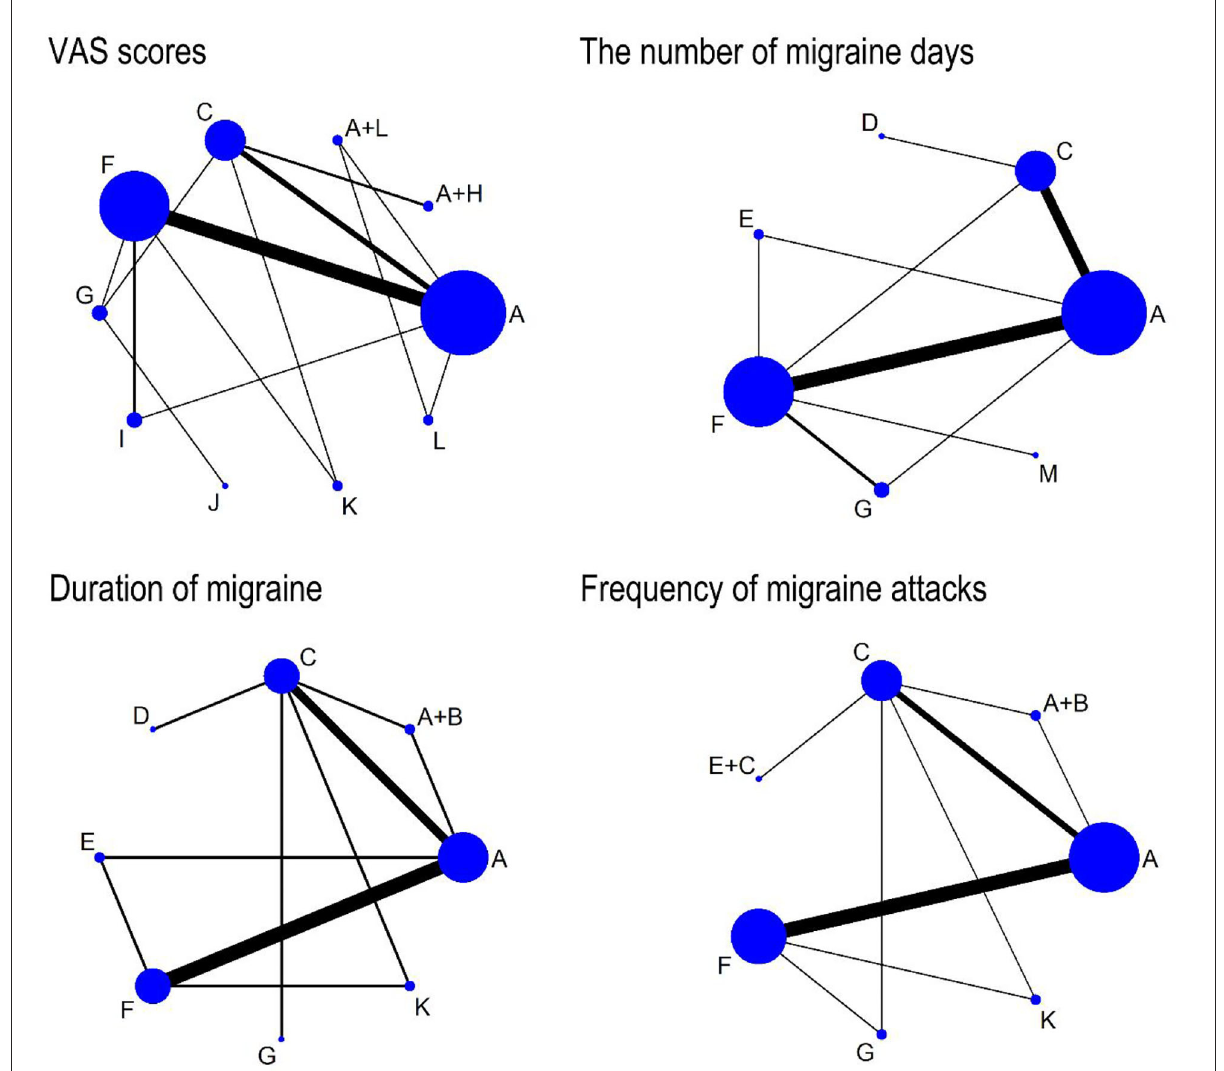
FIGURE4 The network comparisons for the outcome of VAS scores, the number of migraine days, duration of migraine, and frequency of migraine attacks. Each node represents an intervention and the size of each node represents the number of randomly assigned participants. Each line represents a direct comparison between interventions and the width of the lines represents the number of studies. A, conventional acupuncture; B, massage; C, analgesic; D, embedding needle therapy; E, acupressure; F, placebo; G, electroacupuncture; H, cupping; I, auricular acupuncture; J, acupoint implantation; K, acupoint injection; L, traditional Chinese medicine; M, laser